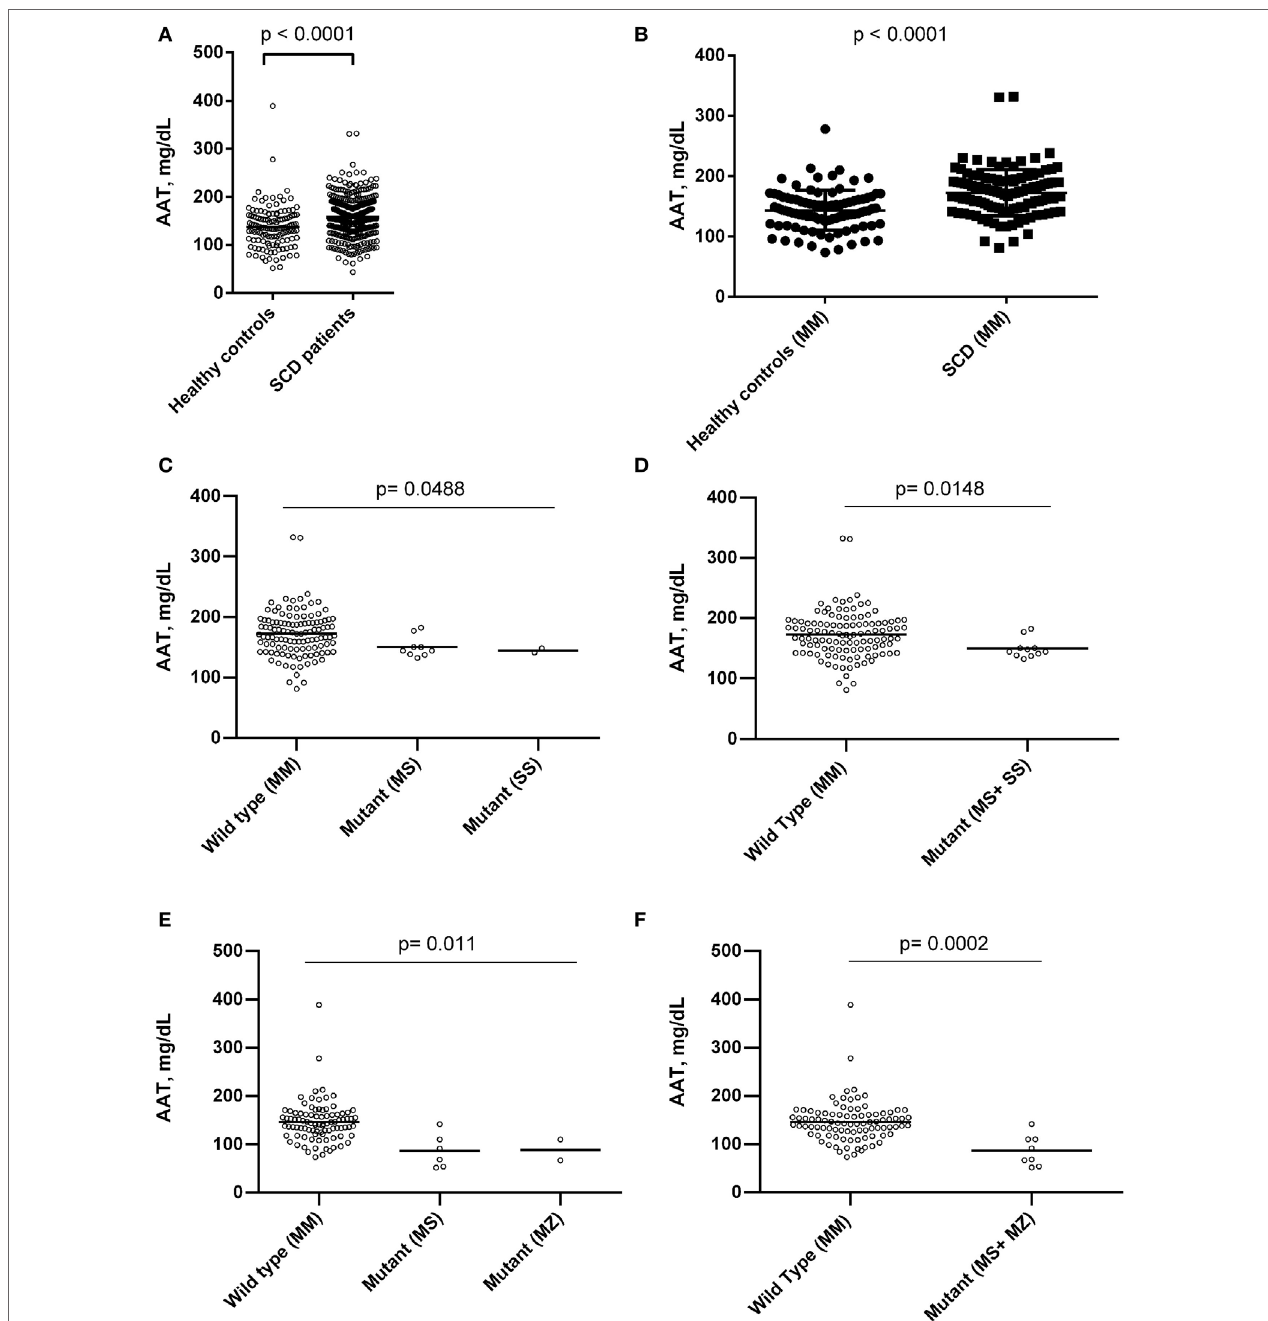
FigUre 1 | Association of alpha-1 antitrypsin (AAT) concentrations between healthy controls individuals and sickle cell disease (SCD) patients in steady state, and with mutations in SERPINA1 gene between steady-state SCD patients and individuals of control group. (a) AAT levels between SCD patients and control group; (b) AAT levels between SCD patients and control group with proteinase inhibitor (PI)*MM genotype; (c,D) association of SERPINA1 gene mutations and AAT concentration among SCD patients. SCD patients with genotype PI*MM had higher AAT levels than patients with mutant genotype analyzed separately (PI*MS and PI*SS) and together. (e,F) Association of SERPINA1 gene mutations and AAT concentration among control group individuals. Control groups individuals with genotype PI*MM had higher AAT levels than individuals with mutant genotype analyzed separately (PI*MS and PI*MZ) and